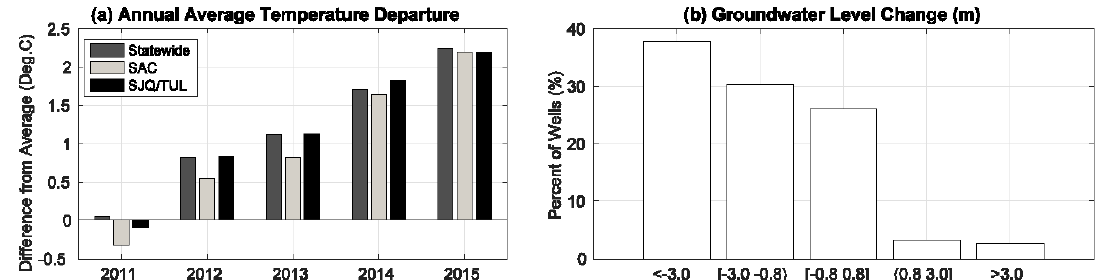
Figure 3. ( a ) Annual average temperature departures from long-term average values (°C) statewide and over three hydrologic regions in the Central Valley. X -axis represents water years. ( b ) Ground level change (m) of statewide (2109) wells between Fall 2010 and Fall 2015. X -axis denotes five categories of groundwater level changes. Negative (positive) numbers represent decrease